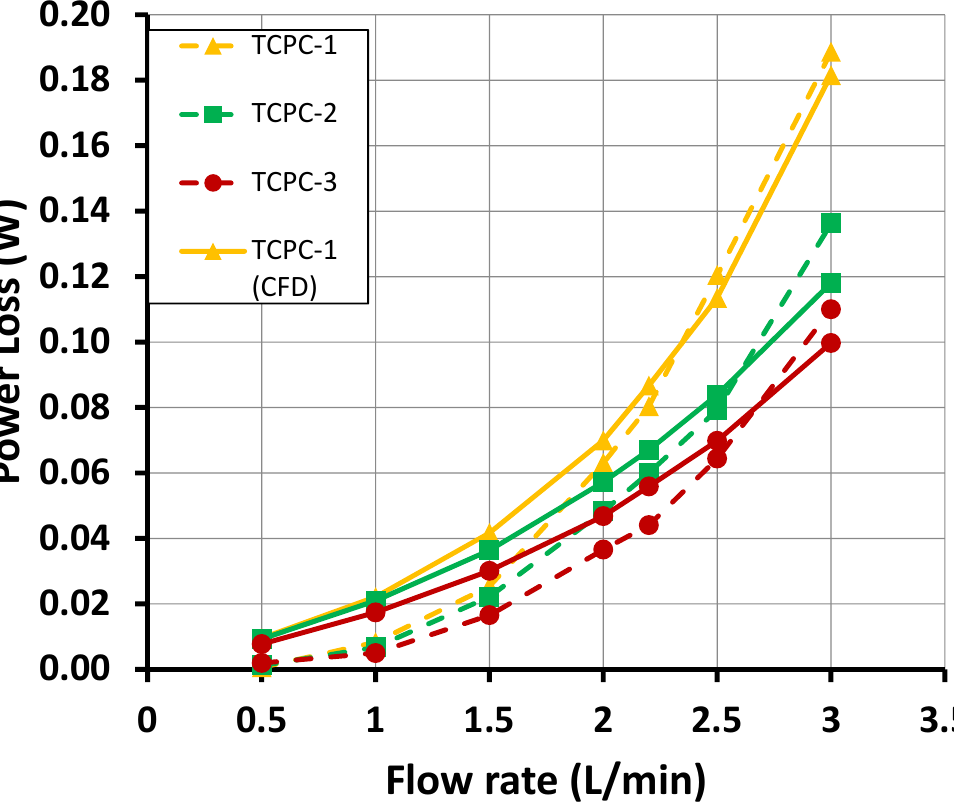
Figure 13. Comparison of power loss of TCPC systems for experimental setup (dashed line) and computational fluid dynamics simulation (solid line). Yellow, green, and red lines correspond to TCPC 1–3 models, respectively.